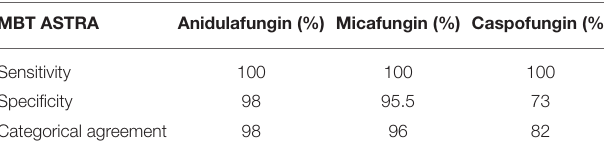
TABLE 4 | Sensitivity, specificity, and categorical agreement of MBT ASTRA in comparison to CLSI microdilution results for anidulafungin, micafungin, and caspofungin.